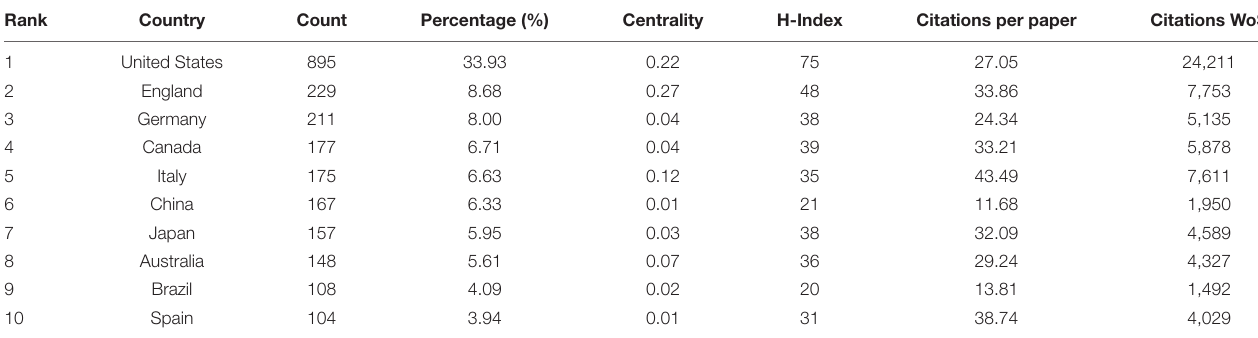
FIGURE 1 | Overview research publications and citation count of physical activity therapy for diabetes from 2011 to 2020. TABLE 2 | The top 10 prolific countries in physical activity therapy for diabetes